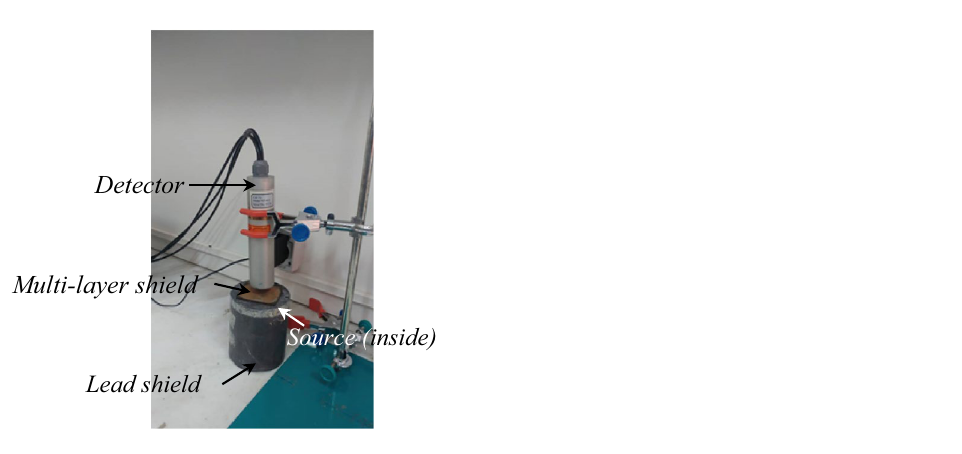
Figure 10. Configuration of irradiation measurement setup using a CsI (Tl) detector (with 1 ″ × 1 ″ size of scintillator crystal).